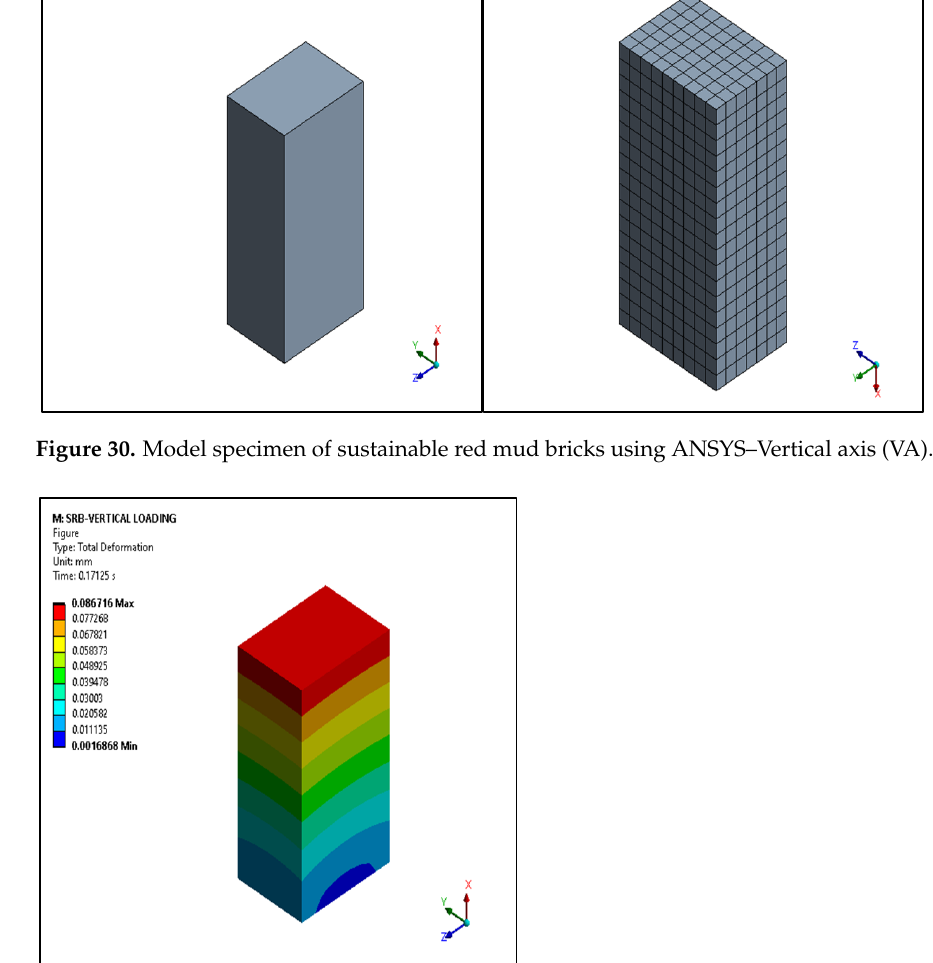
Figure 31. Total deformation of sustainable red mud bricks using ANSYS.